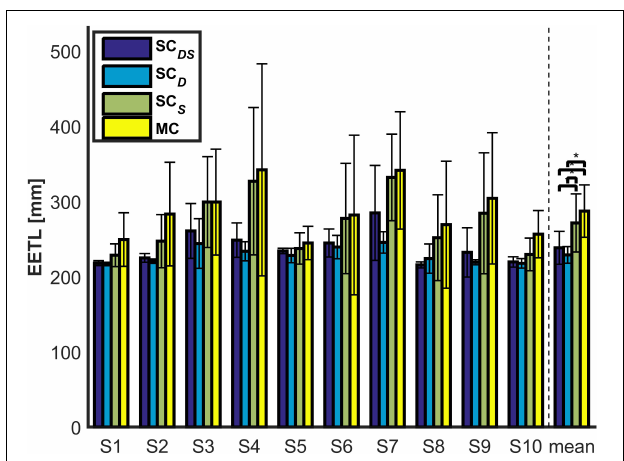
FIGURE 8 | The EETLs for each subject and across subjects (the across-subjects performance difference with statistical significance is marked by “*”, p < 0.05).